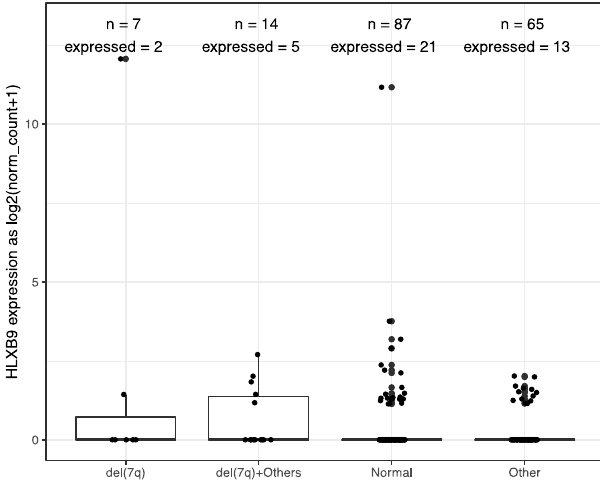
Figure 2. HLXB9 expression level distribution in 173 TCGA AML samples stratified by cytogenetic phenotypes, where "n" signifies the total number of samples in each class, while "expressed" indicates the number of samples with HLXB9 expression level higher than 1.